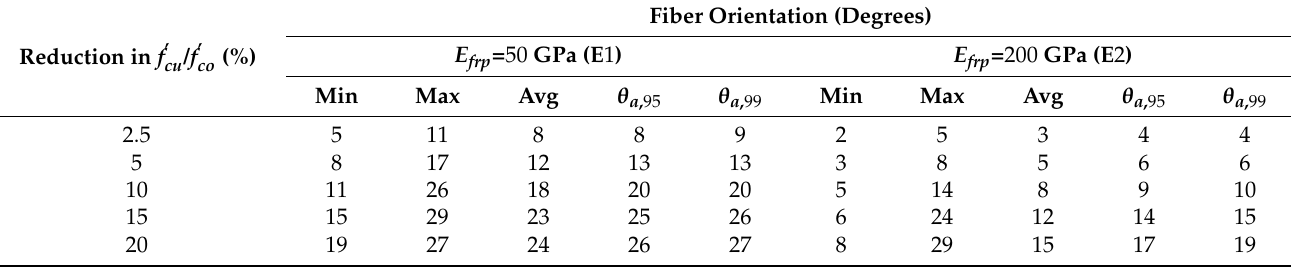
Fiber Orientation (Degrees)